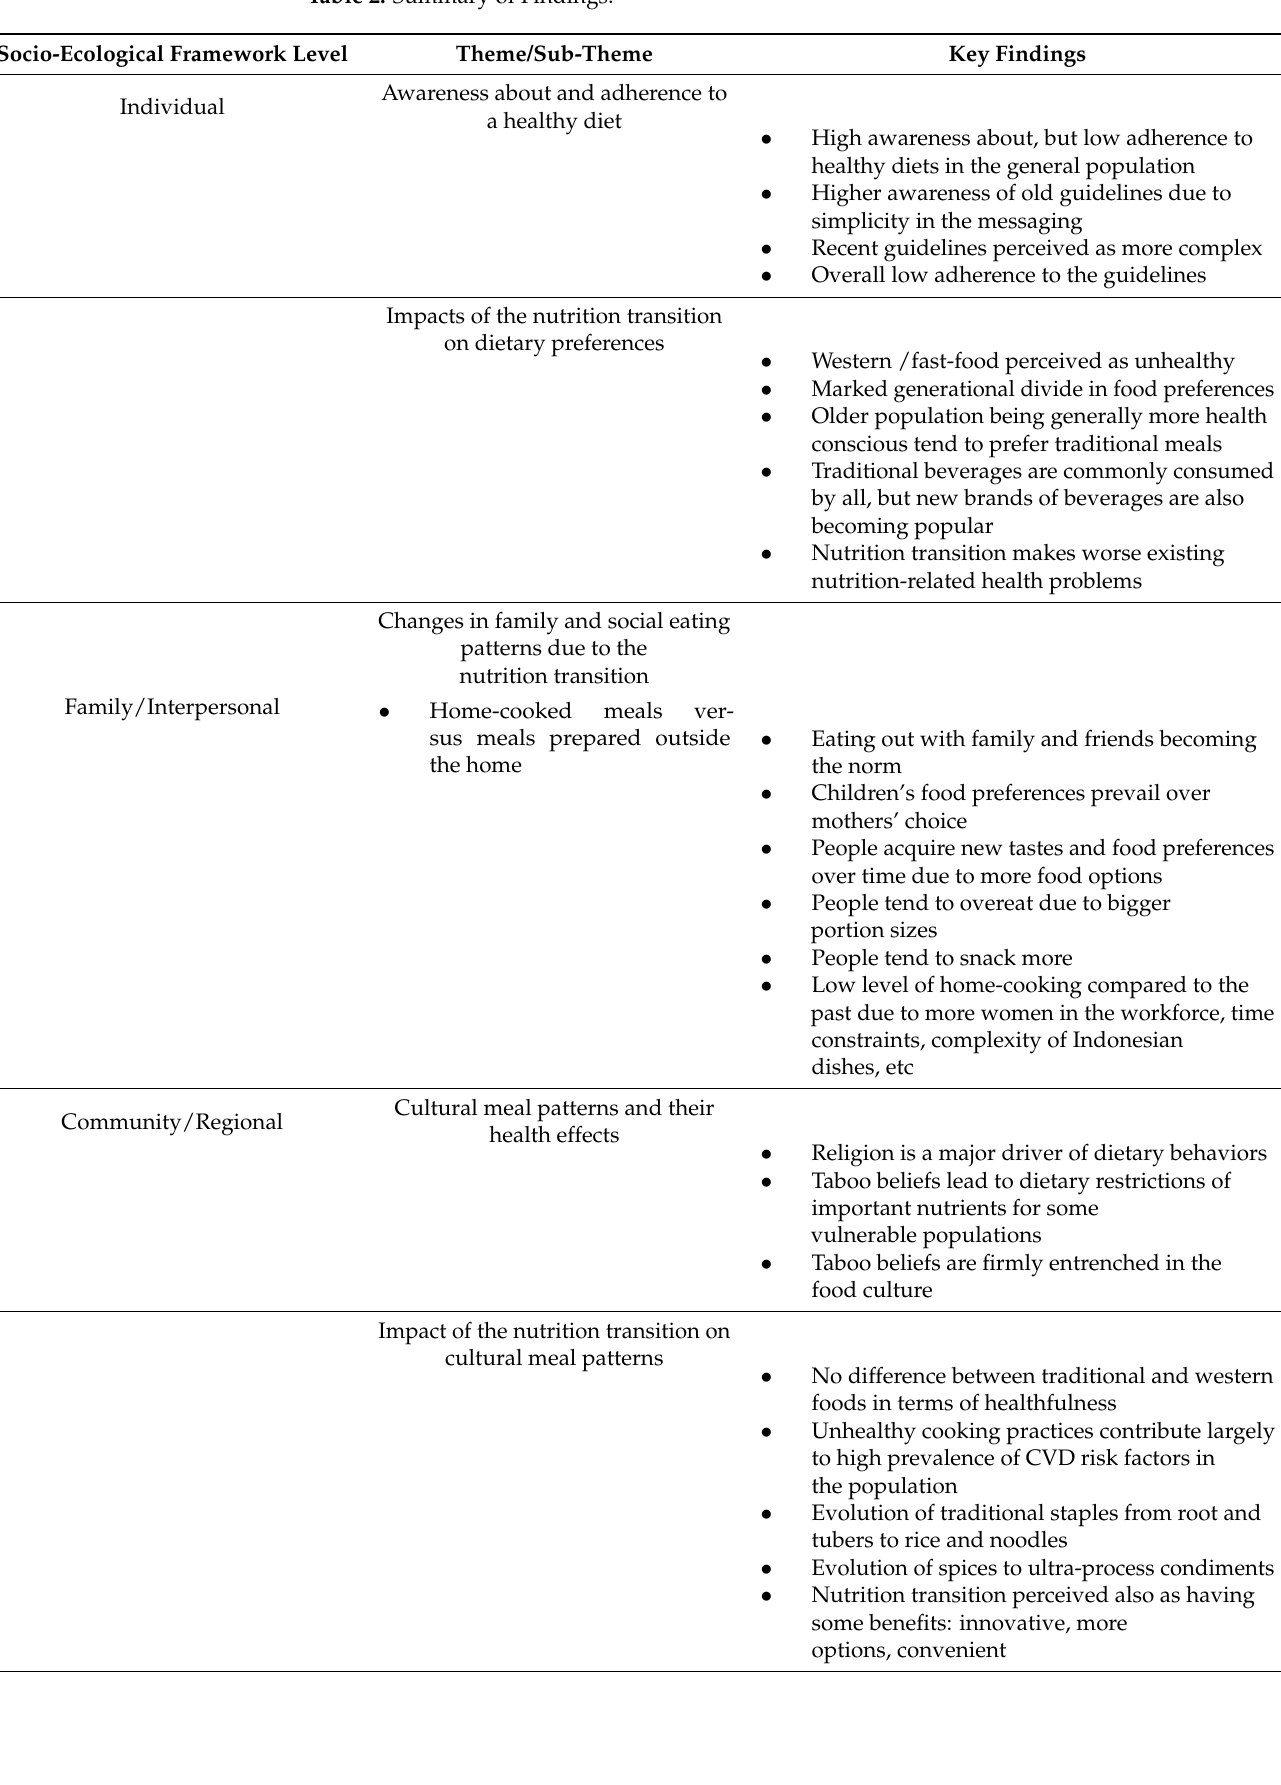
Table 2. Summary of